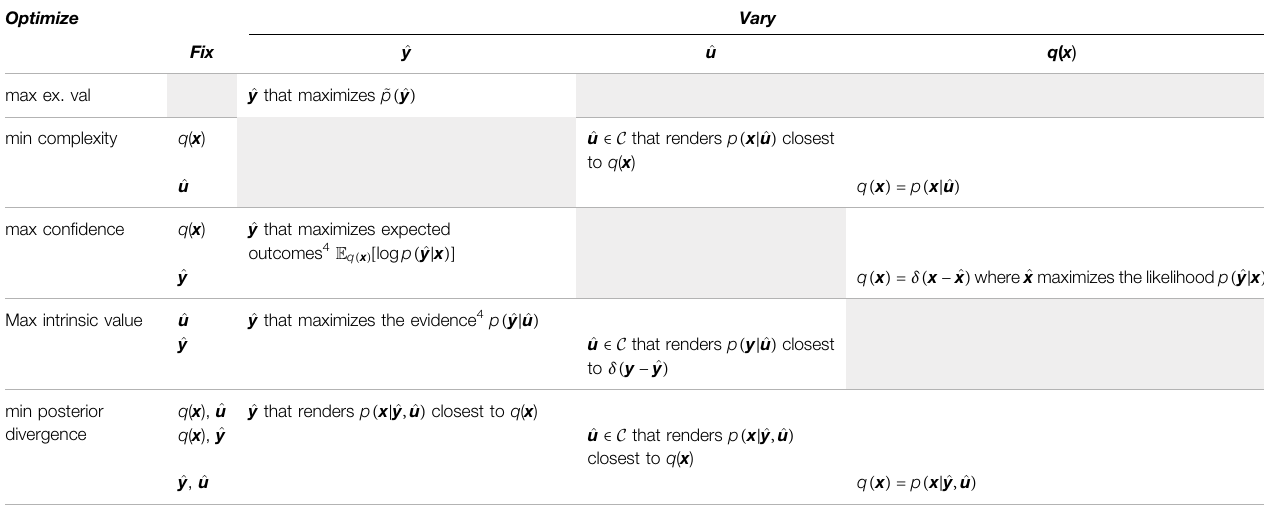
TABLE2| OptimafortheindividualtermsoftheCBFEdecompositions( Eq.32 , Eq.34 ).Eachrowvariesonequantity(variableorfunction)intheirrespectivetermwhileother quantities remain fi xed. Shaded cells indicate that the term (row) is not a function(al) of that speci fi c optimization quantity (column). Optimize